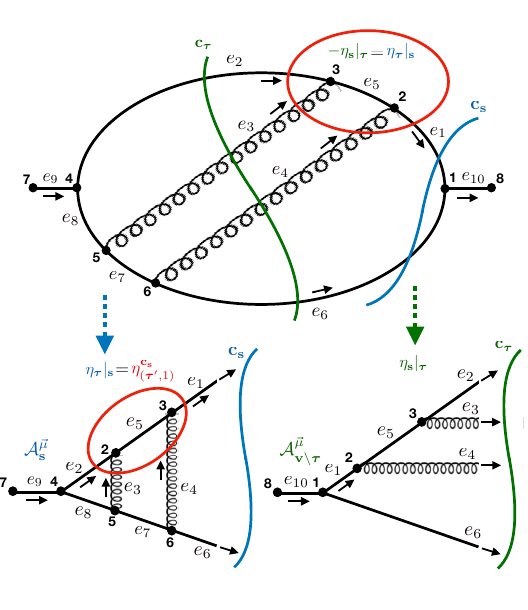
Figure 5. Example of a supergraph E-surface η τ | s ( = − η s | τ ) identified by the two sets of ver- tices s = { 2 , 3 , 4 , 5 , 6 , 7 } and τ = { 4 , 5 , 6 , 7 } defining the two Cutkosky cuts c = { e s 1 , e 6 } and c = { e . The two-loop ampli- τ 2 , e 3 , e 4 , e 6 } tude A ~µ on the left of the Cutkosky cut c has s s an amplitude E-surface η c s , with τ 0 = s \ τ = ( τ 0 , 1) { 2 , 3 } , which is pinched for − ~q i = x i ~p τ 0 , ~q m = − x m ~p τ 0 , ~q l = − x l ~p τ 0 , ∀ i ∈ { e 1 } , ∀ m ∈ ∅ , ∀ l ∈ { e 2 , e 3 , e 4 } , with ~p τ 0 = − q 1 . More concisely, for x i > 0 , the pinch happens for ~q 1 //~q 2 //~q 3 //~q 4 . The complex-conjugate of the tree-level ampli- tude A ~µ on the right of the Cutkosky cut c τ v \ τ has no amplitude E-surfaces, but instead features the familiar real-emission triple-collinear phase- space singularity which, within the LU frame- work, cancels A ~µ on the pinch of its amplitude s